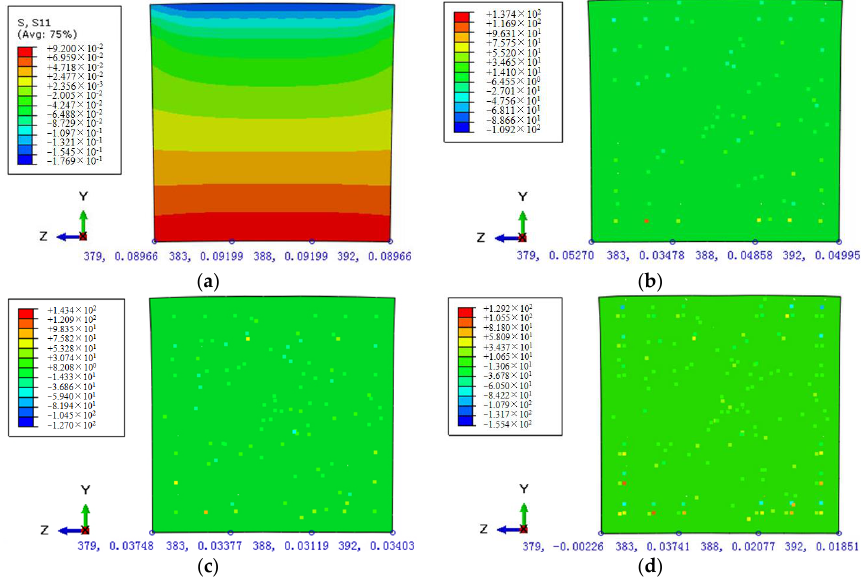
Figure 15 . Stress contours of the midspan cross section under different BF contents at 3600 s as: ( a ) Figure 15. Stress contours of the midspan cross section under di ff erent BF contents at 3600 s as: control; ( b ) 0.1% fiber content; ( c ) 0.2% fiber content; ( d ) 0.3% fiber content. ( a ) control; ( b ) 0.1% fiber content; ( c ) 0.2% fiber content; ( d ) 0.3% fiber